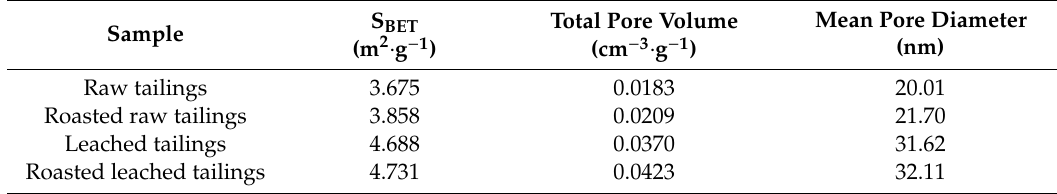
Table 5. Structural surface characteristics of the specimens.